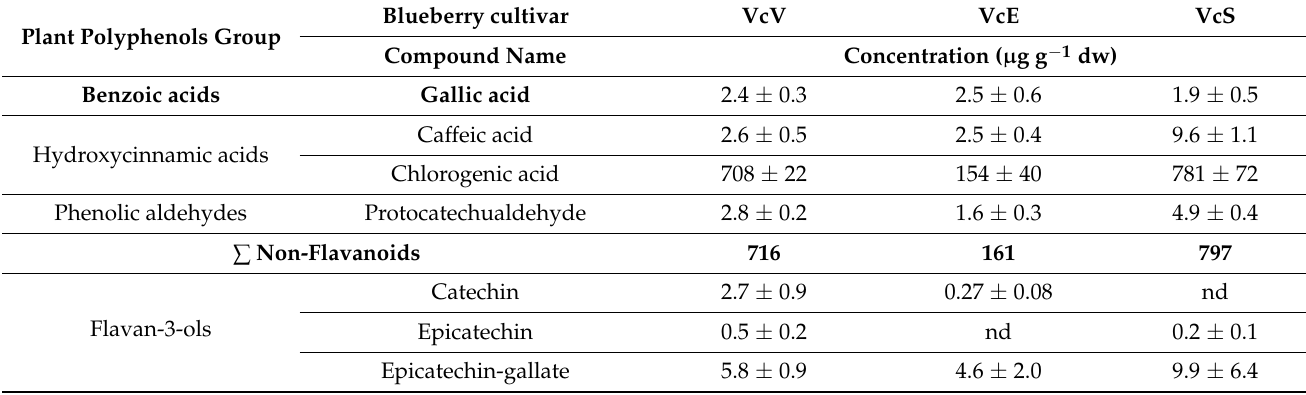
Table 1. Polyphenolic composition of saline blueberry extracts obtained by MSATs from three different commercial varieties. Plant Polyphenols